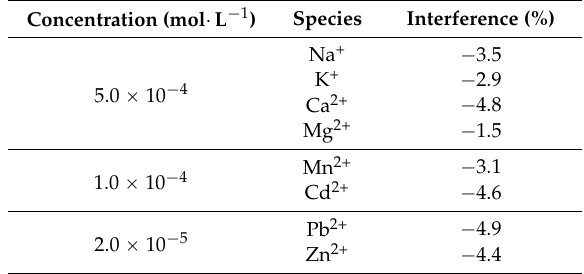
Table 3. ( i o ´ i p )/ i p of sensor for 1.0 ˆ 10 ´ 6 mol ¨ L ´ 1 Cu(II) in the presence of other metal ions.